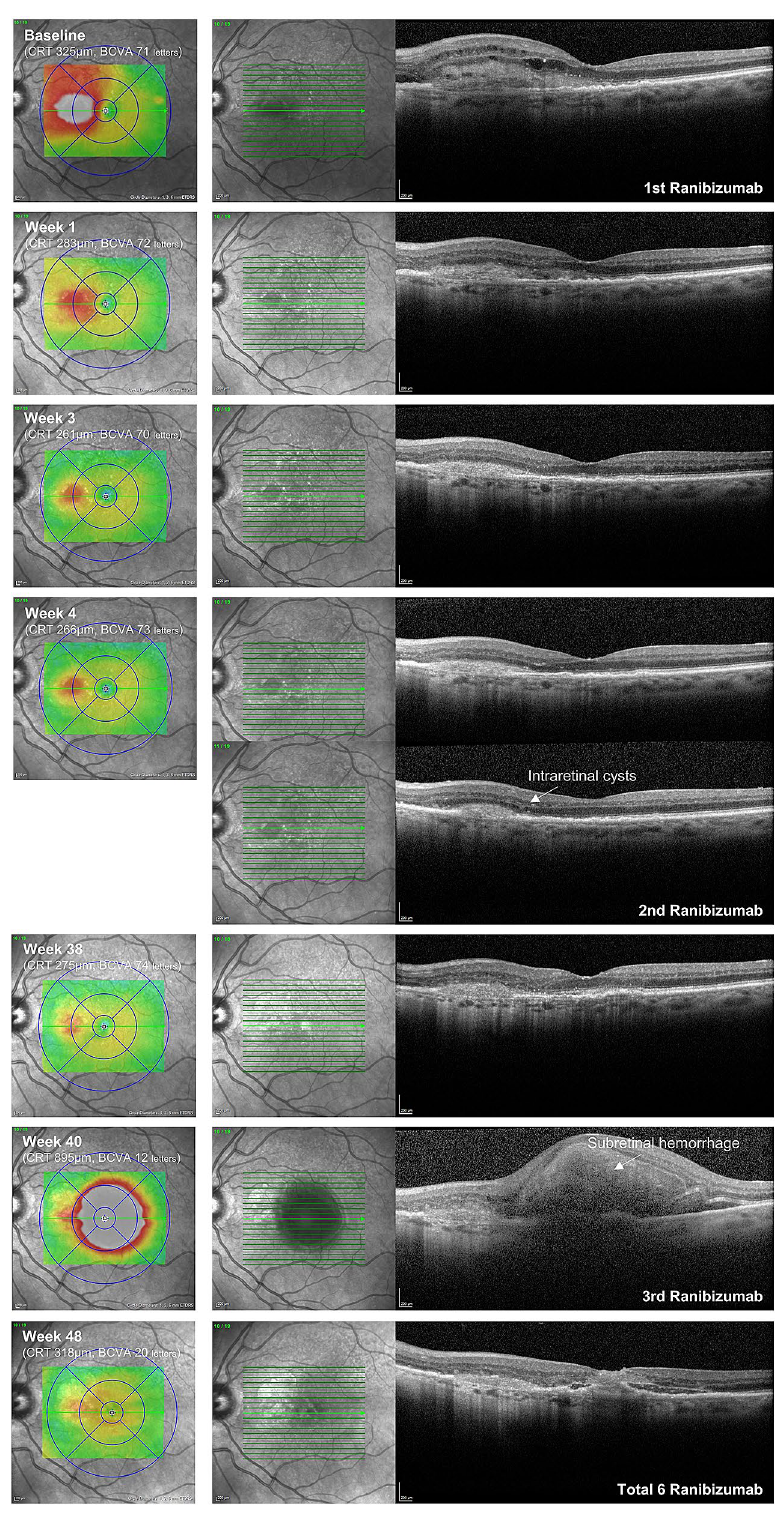
Figure 4. Baseline and selected follow-up SD-OCT scans of a patient having experienced an extensive subretinal hemorrhage at week 40. Left column – thickness map, right column – SD-OCT